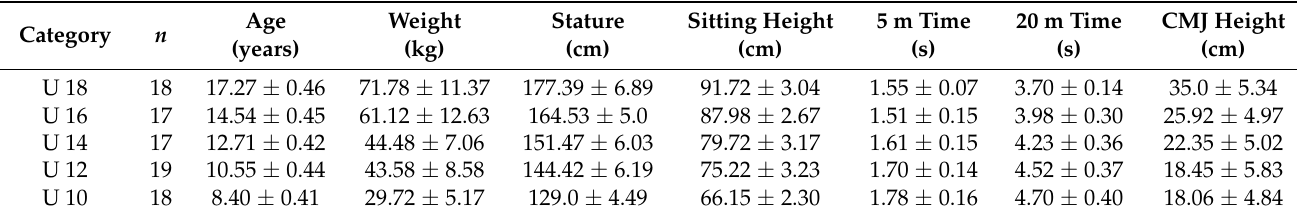
Table 1. Descriptive statistics (mean ± standard deviation) of chronological age, body mass, stature, sitting height, 5 m sprint time, 20 m sprint time, and countermovement jump (CMJ) height of participants for each category.